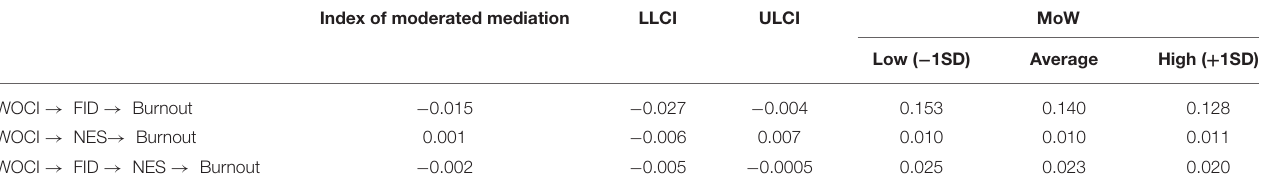
TABLE 3 | Indices of moderated mediation and specific indirect and serial indirect relationships at low, average, and high levels of meaning of